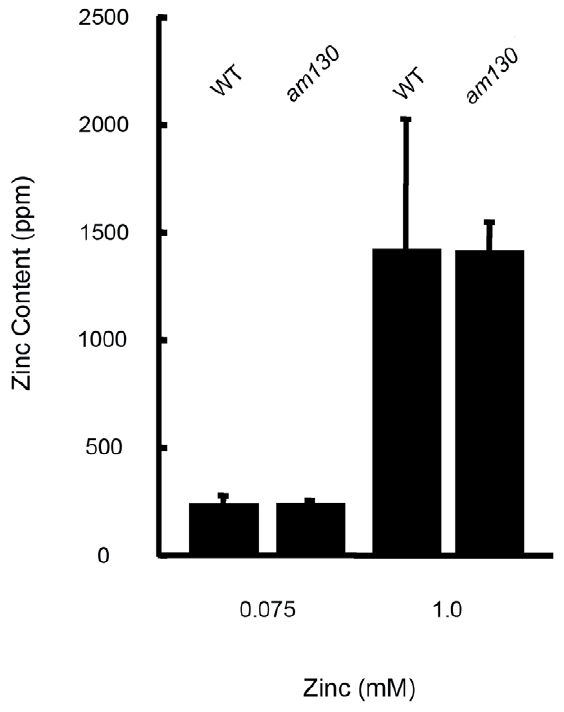
Figure 5. Wild-type and haly-1 mutant animals have similar total zinc content. Populations of wild-type and haly-1(am130) animals consisting of a mixture of developmental stages were cultured in CeMM with the indicated levels of zinc. Total zinc content was determined by ICP-MS and calculated in parts per million (ppm). Bars indicate mean values 6 SE (n=2 independent replicates). Values for wild-type and haly-1(am130) animals were not significantly different at 0.075 mM (p=0.6) and 1 mM